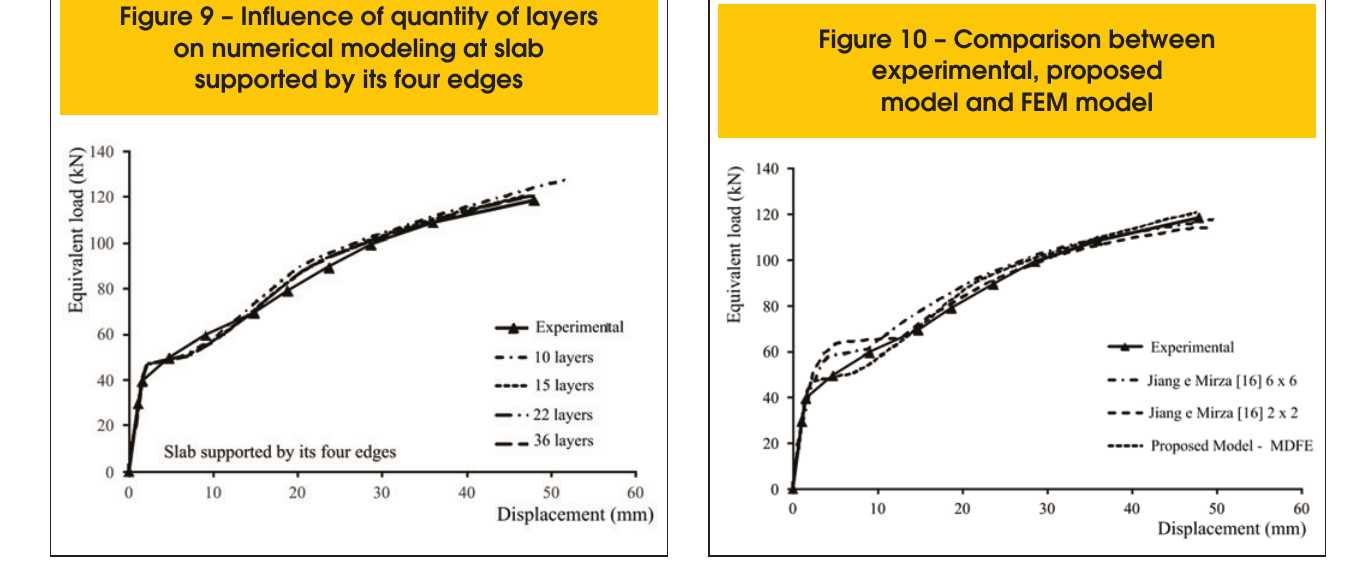
Figure 9 – Influence of quantity of layers on numerical modeling at slab supported by its four edges